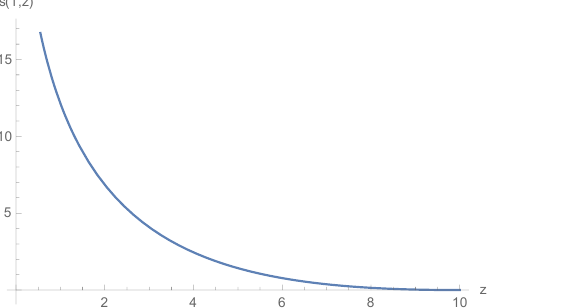
Figure 1. The optimal value function s with respect to z at time t =